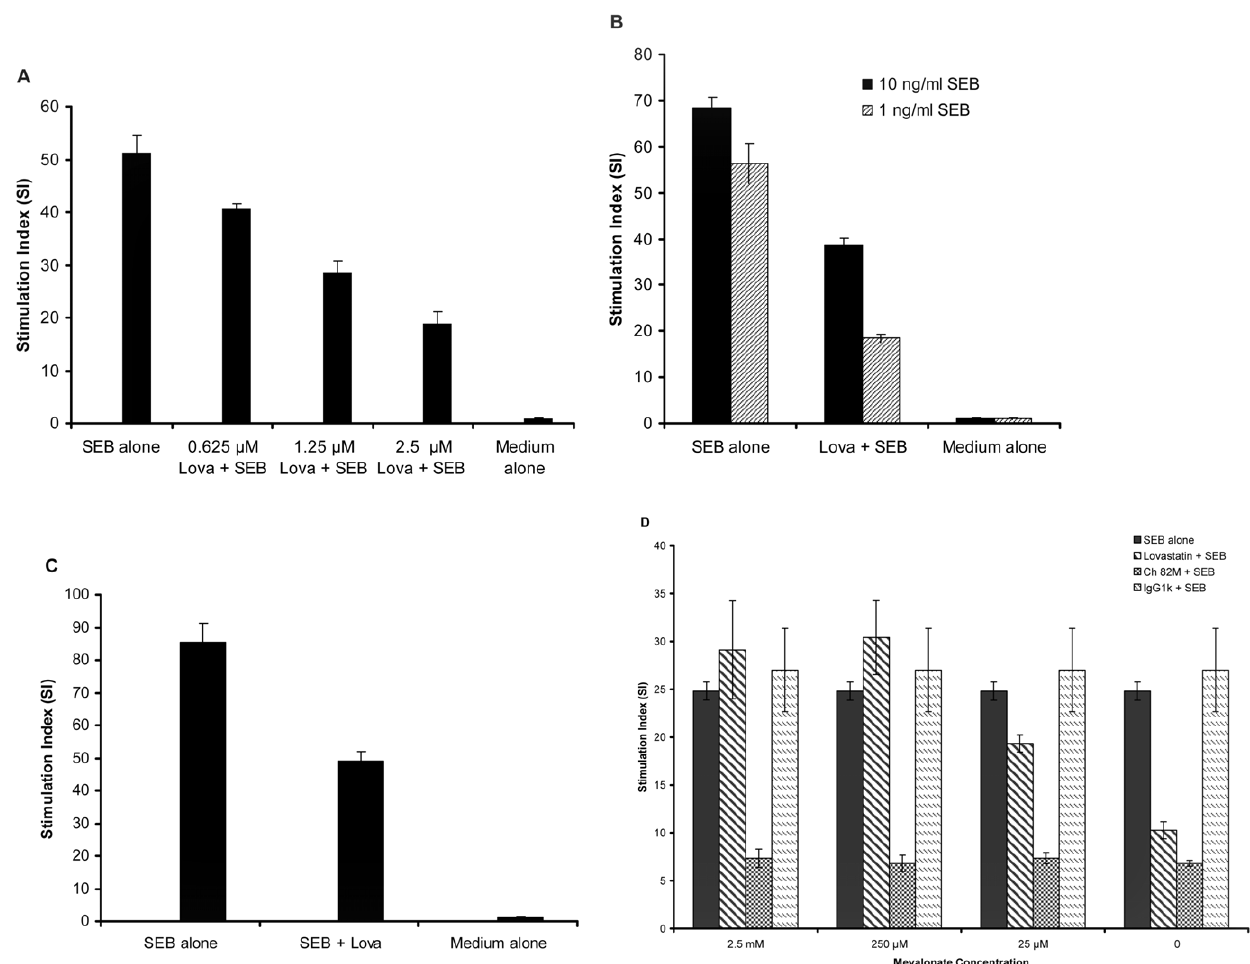
Figure 2. Neutralization of SEB-induced T-cell proliferation by lovastatin. ( A ) In vitro neutralization in BALB/c splenocytes. BALB/c splenocytes (5 6 105 cells/well) were incubated at 37 u C for 48 hours in the presence of medium alone, SEB alone (100 ng/ml), SEB + different concentrations of lovastatin (0.625 m M, 1.25 m M, and 2.5 m M) as indicated. Cells were then pulsed with 3H-thymidine (1 m ci/well), incubated for an additional 18 hours, harvested and cell proliferation determined by measuring 3H-thymidine incorporation. Each bar represents the means 6 s.d. of triplicate measurements, and the data shown are representative of two or more independent experiments. Neutralization of SEB-induced T-cell proliferation by lovastatin were significant (P , 0.01) compared with results obtained with SEB alone. ( B ) SEB neutralization in HLA-DR3 transgenic mice splenocytes. HLA-DR3 splenocytes (5 6 105 cells/well) were incubated at 37 u C for 48 hours in the presence of medium alone, with various concentration of SEB alone (10 ng/ml and 1 ng/ml), or SEB plus lovastatin (2.5 m M). Cells were then pulsed with 3H-thymidine (1 m ci/well), incubated for an additional 18 hours, harvested and cell proliferation determined by measuring 3H-thymidine incorporation. Each bar represents the means 6 s.d. of triplicate measurements, and the data shown are representative of two or more independent experiments. Neutralization of SEB-induced T-cell proliferation by lovastatin were significant ( P , 0.01) compared to cells treated with SEB alone. ( C ) SEB neutralization in human PBMC. Human PBMC (5 6 105 cells/well) were incubated at 37 u C for 48 hours in the presence of medium alone, SEB alone (1 ng/ml), or SEB plus lovastatin (2.5 m M). Cells were then pulsed with 3H-thymidine (1 m ci/well), incubated for an additional 18 hours, harvested and cell proliferation determined by measuring 3H- thymidine incorporation. Each bar represents the means 6 s.d. of triplicate measurements, and the data shown are representative of two or more independent experiments. Neutralization of SEB-induced T-cell proliferation by lovastatin were significant ( P , 0.01) compared to cells treated with SEB alone. ( D ) Mevalonate mediated reversal of lovastatin’s inhibition of SEB in BALB/c splenocytes. Bar groups are organized by the amount of mevalonate added to each well. BALB/c splenocytes (5 6 105 cells/well) were incubated at 37 u C for 48 hours with various concentration of mevalonate (25 mM, 250 m M, 25 m M or 0), and in the presence of SEB alone (100 ng/ml SEB); lovastatin + SEB (2.5 m M lovastatin + 100 ng/ml SEB); Ch 82 M + SEB (10 m g/ml chimeric anti-SEB 82 M + 100 ng/ml SEB); IgG1 k + SEB (10 m g/ml human IgG1 k isotype control + 100 ng/ml SEB). Cells were then pulsed with 3H-thymidine (1 m ci/well), incubated for an additional 18 hours, harvested and cell proliferation determined by measuring 3H-thymidine incorporation. Each bar represents the means 6 s.d. of triplicate measurements, and the data shown are representative of two or more independent experiments. Inhibition of SEB by lovastatin was not significant (P . 0.05) at 25 m M